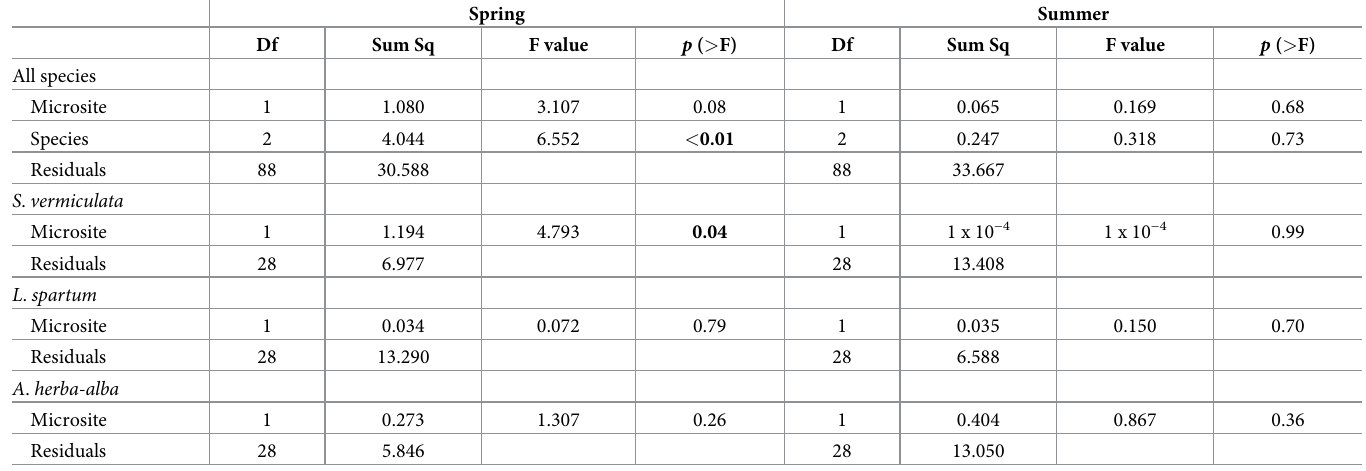
Table 4. Result of ANOVA analyses for the net interaction outcome of shrub microsites under the two drought stress conditions. Spring